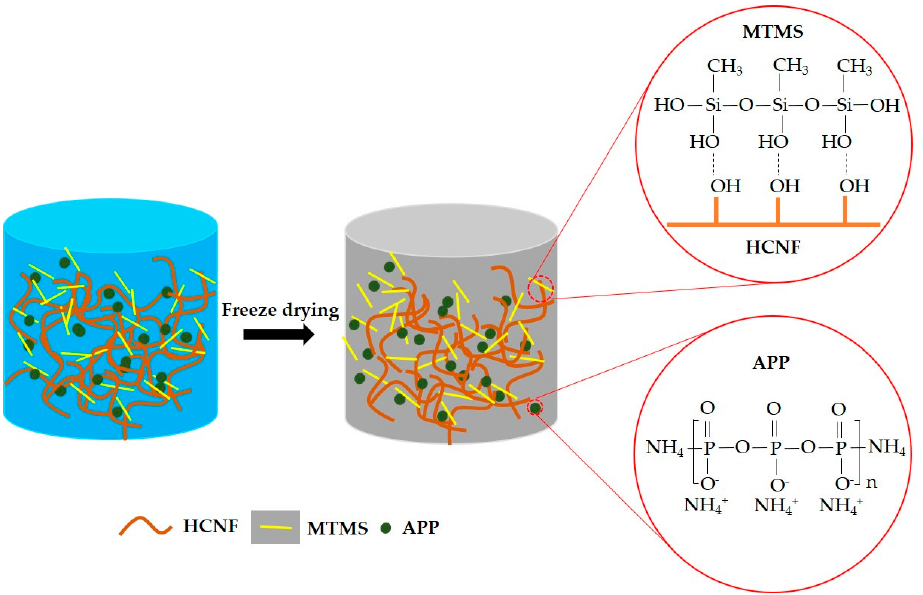
Figure 1. The mechanism scheme for HCNF/APP/MTMS aerogels.